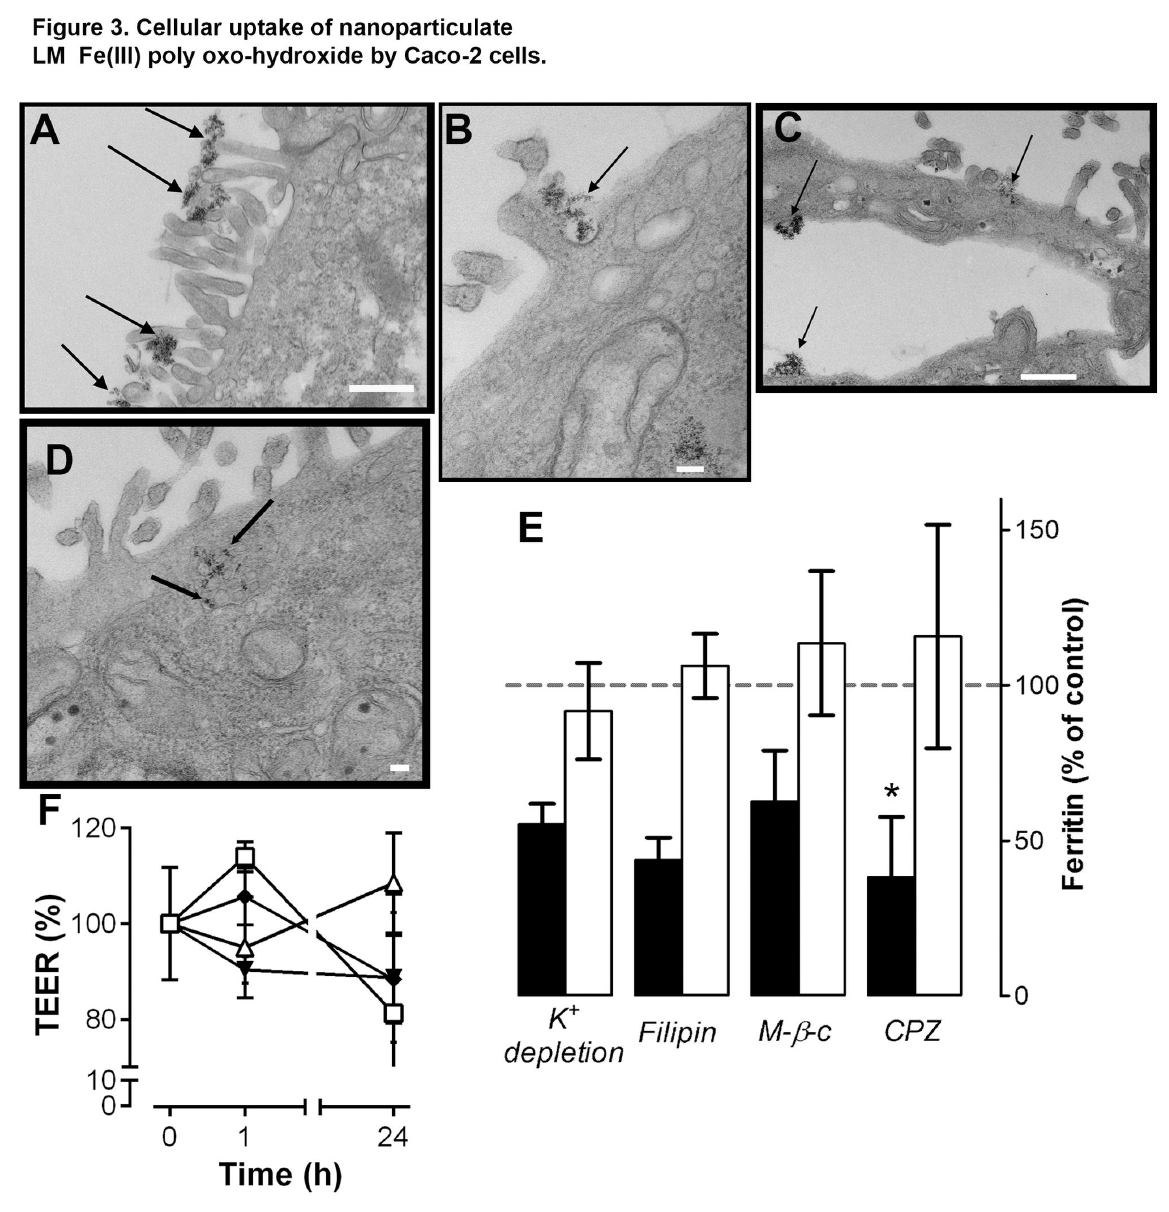
Figure 3. Cellular uptake of nanoparticulate LM Fe(III) poly oxo-hydroxide by Caco-2 cells. A, B, C, D TEM images showing differentiated Caco-2 cells incubated with LM Fe(III) poly oxo-hydroxide. A , arrows show particle clusters adhering to the cell membrane microvilli (scale bar, 500 nm). B , arrows indicate invagination on the cell membrane (scale bar, 100 nm). C and D , arrows indicate Fe accumulation inside the cell (scale bars: panel C, 500 nm and panel D, 100 nm). E , Effect of chemical inhibitors of endocytosis-related pathways on Fe utilization by differentiated Caco-2 cells. Data are shown as a percentage of the controls (without inhibitor) after a 1 h exposure to LM Fe(III) poly oxo-hydroxide (black bars) or Fe(III) maltol (open bars) co-incubated with either chlorpromazine (CPZ), potassium-free BSS (K + depletion), filipin or methyl-β-cyclodextrin (M-β-c), plus 23 h in fresh non- supplemented MEM. Results are mean ± s.d. of 3 independent experiments with 3 replicate wells per experiment for chlorpromazine (*, p =0.02 relative to control) or triplicate wells of the same experiment for the remaining inhibitors. F , Change in TEER in the Caco-2 cell monolayer following a 1 h exposure to chlorpromazine (closed diamonds), K + -free BSS (open triangles), M-β-c (open squares) or non-supplemented BSS (closed inverted triangles) and with 23 h further incubation in fresh MEM (24 h total). Values are a percentage of the initial measurement (0 h) and are shown as mean ± s.d. as above. Experimental points are connected with a solid line to aid visualization and not because a linear relationship is assumed between time and TEER measurement. Detailed methodology is available in the Methods Section and in Methods S1. doi: 10.1371/journal.pone.0081250.g003 PLOS ONE |